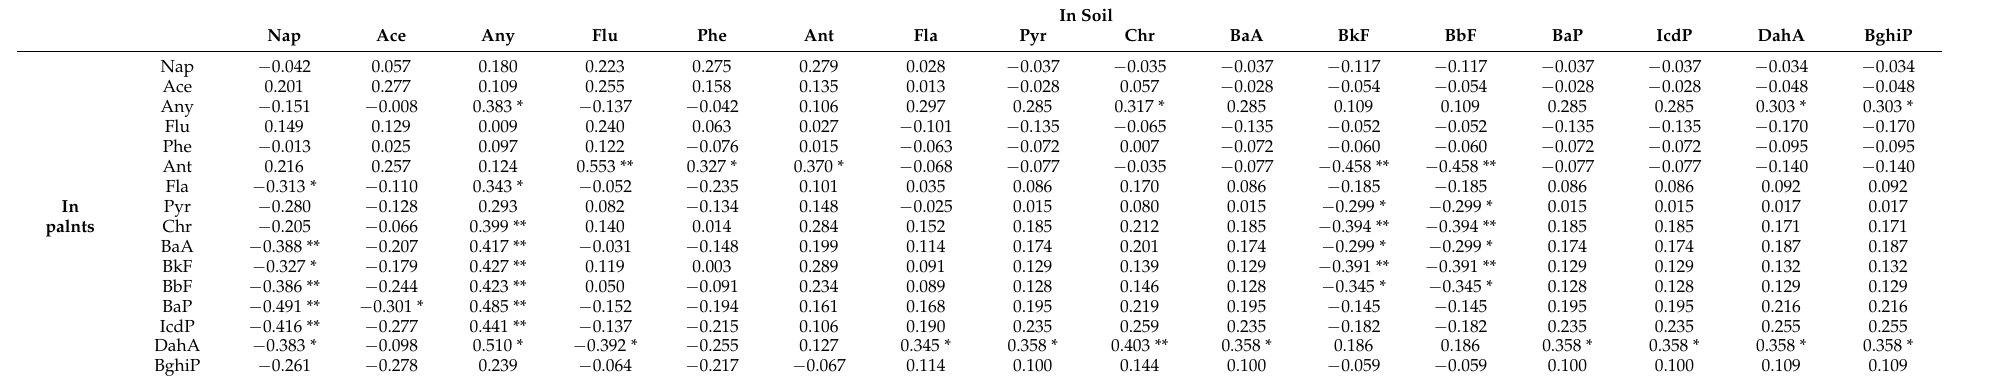
Table 4. Correlation coefficient between PAH monomer content in soil and